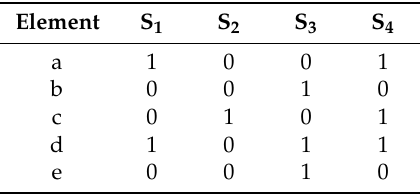
Table 1. The feature matrix of four object